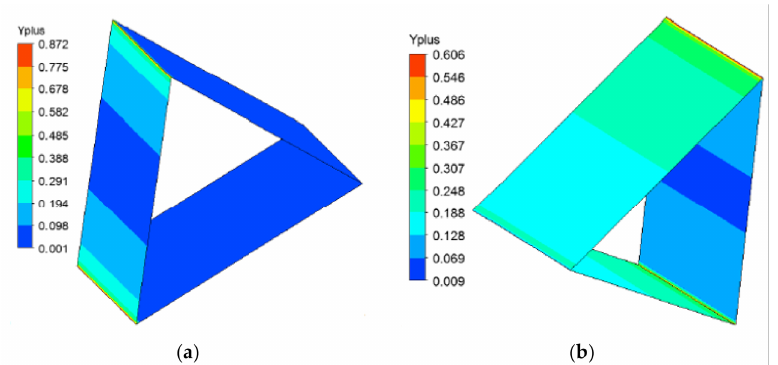
Figure 9. Dimensionless distance y+ to first vertex adjacent to the wall: ( a ) Wind flow direction 1; ( b ) Wind flow direction